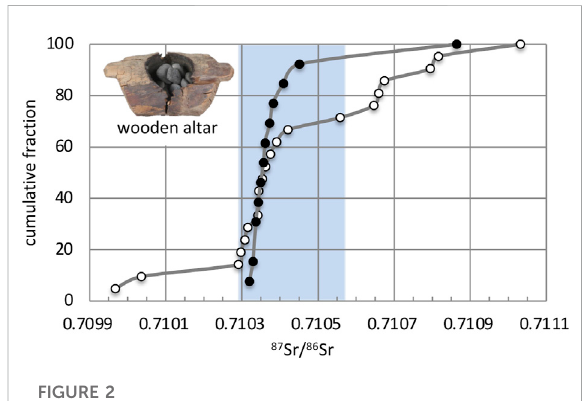
FIGURE 2 Cumulative distribution plot of 87 Sr/ 86 Sr in human enamel from Jirzankal